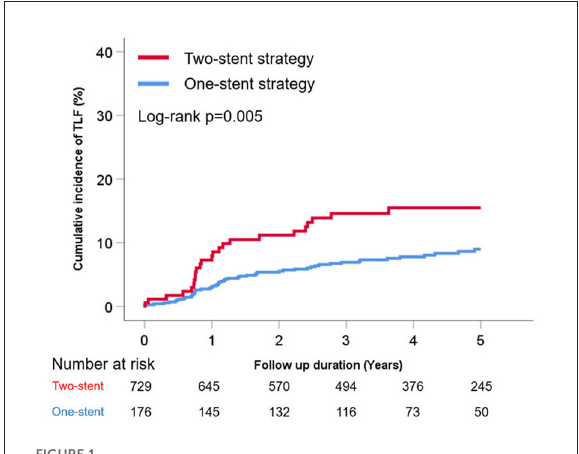
FIGURE1 Cumulative incidence of target lesion failure (TLF) of one- vs. two-stent strategy for treating coronary bifurcation lesions in patients with diabetes mellitus.